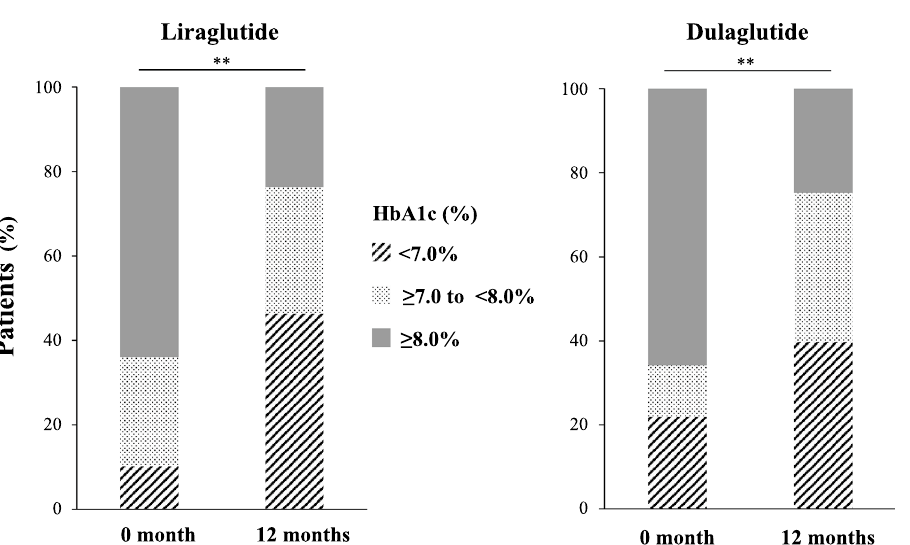
Figure 2. HbA1c target achievement at baseline and 12 months after adjustment by stabilized propensity score- based inverse probability of treatment weighting. **P < 0.01, by McNemar’s test. HbA1c glycated